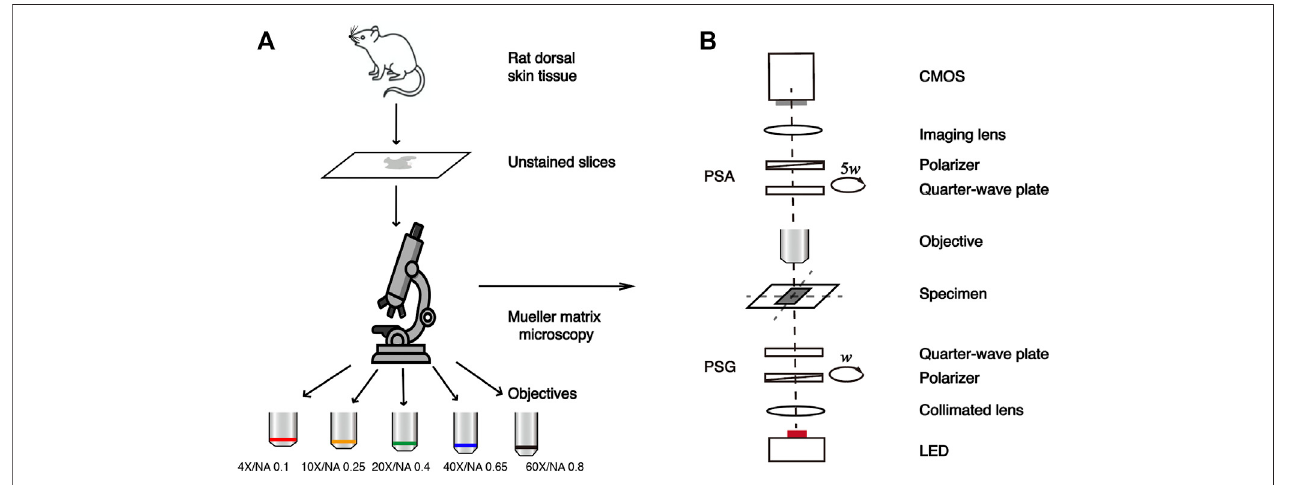
FIGURE 1 | Schematic of the study. (A) Flow chart of the experiment. (B) Schematic of the transmission Mueller matrix